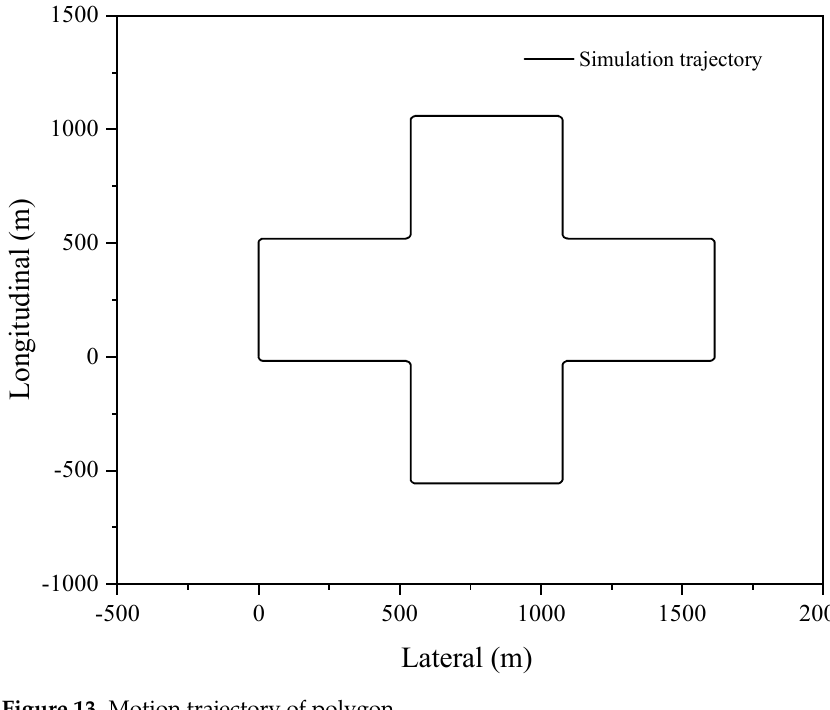
16 of 21 Figure 12. Lateral, Longitudinal and Vertical positions of ESKF − RTS (Serpentine 2). Table 4. RMS values of localization errors for different algorithms (Serpentine 2). Position Error RMS(m)